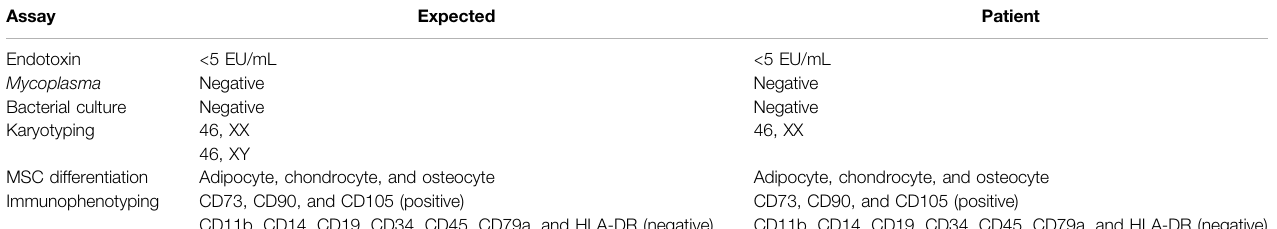
TABLE 3 | Quality control of MSCs.